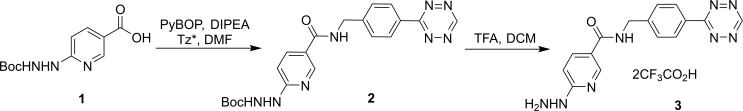
Synthesis scheme for the preparation of 3.A protected form of HYNIC (1) was coupled to a commercially available tetrazine to form 2. The Boc group was removed prior to labelling by treatment with TFA in DCM to produce 3. Tz* = (4-(1,2,4,5-tetrazin-3-yl)phenyl) methanamine.